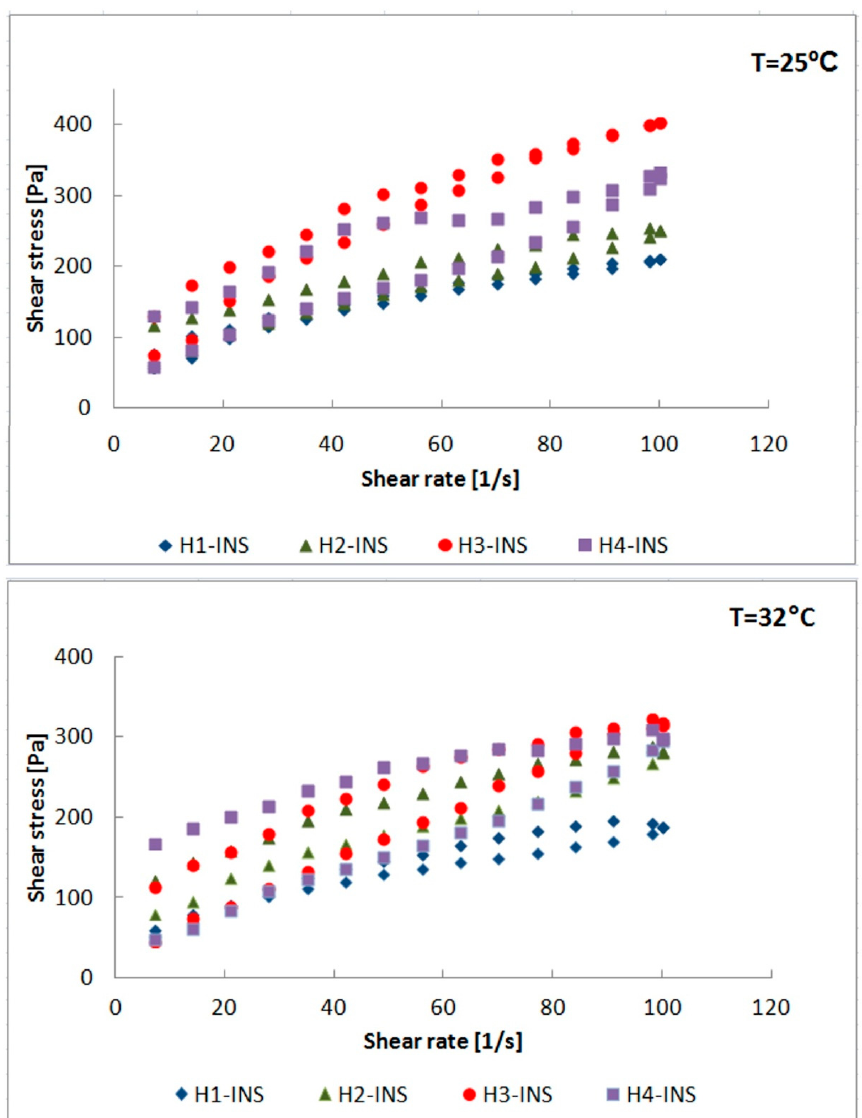
Figure 5. Flow curves hysteresis for H1-INS, H2-INS, H3-INS, and H4-INS (T = 25 ° C; T = 32 ° C). Table 5. The results obtained from mathematical modeling of rheogram.